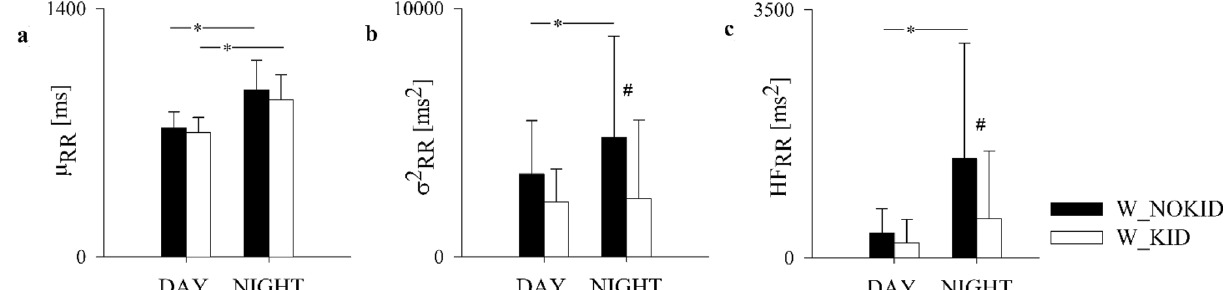
Figure 2. Results of power spectral analysis of heart rate variability during DAY and NIGHT in W_NOKID group (dark bars) and W_KID group (white bars). The indices μ RR ( a ), σ 2 RR ( b ), and HF RR ( c ) are shown. Results are presented as mean ± standard deviation. The symbol * indicates p < 0.05 DAY vs NIGHT. The symbol # indicates p < 0.05 W_KID vs